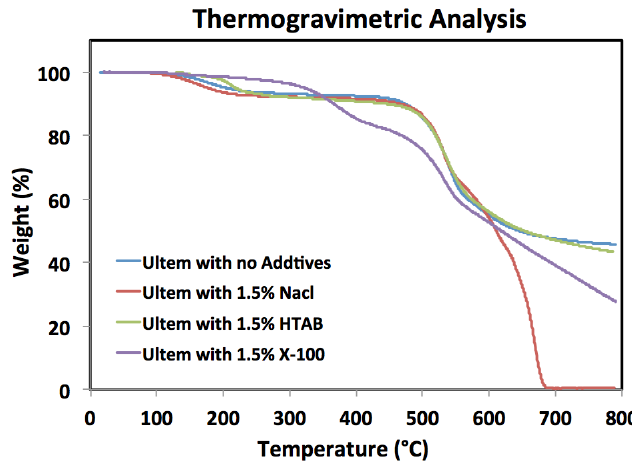
Figure 8. Thermogravimetric analysis of PEI fiber mats with different additives.